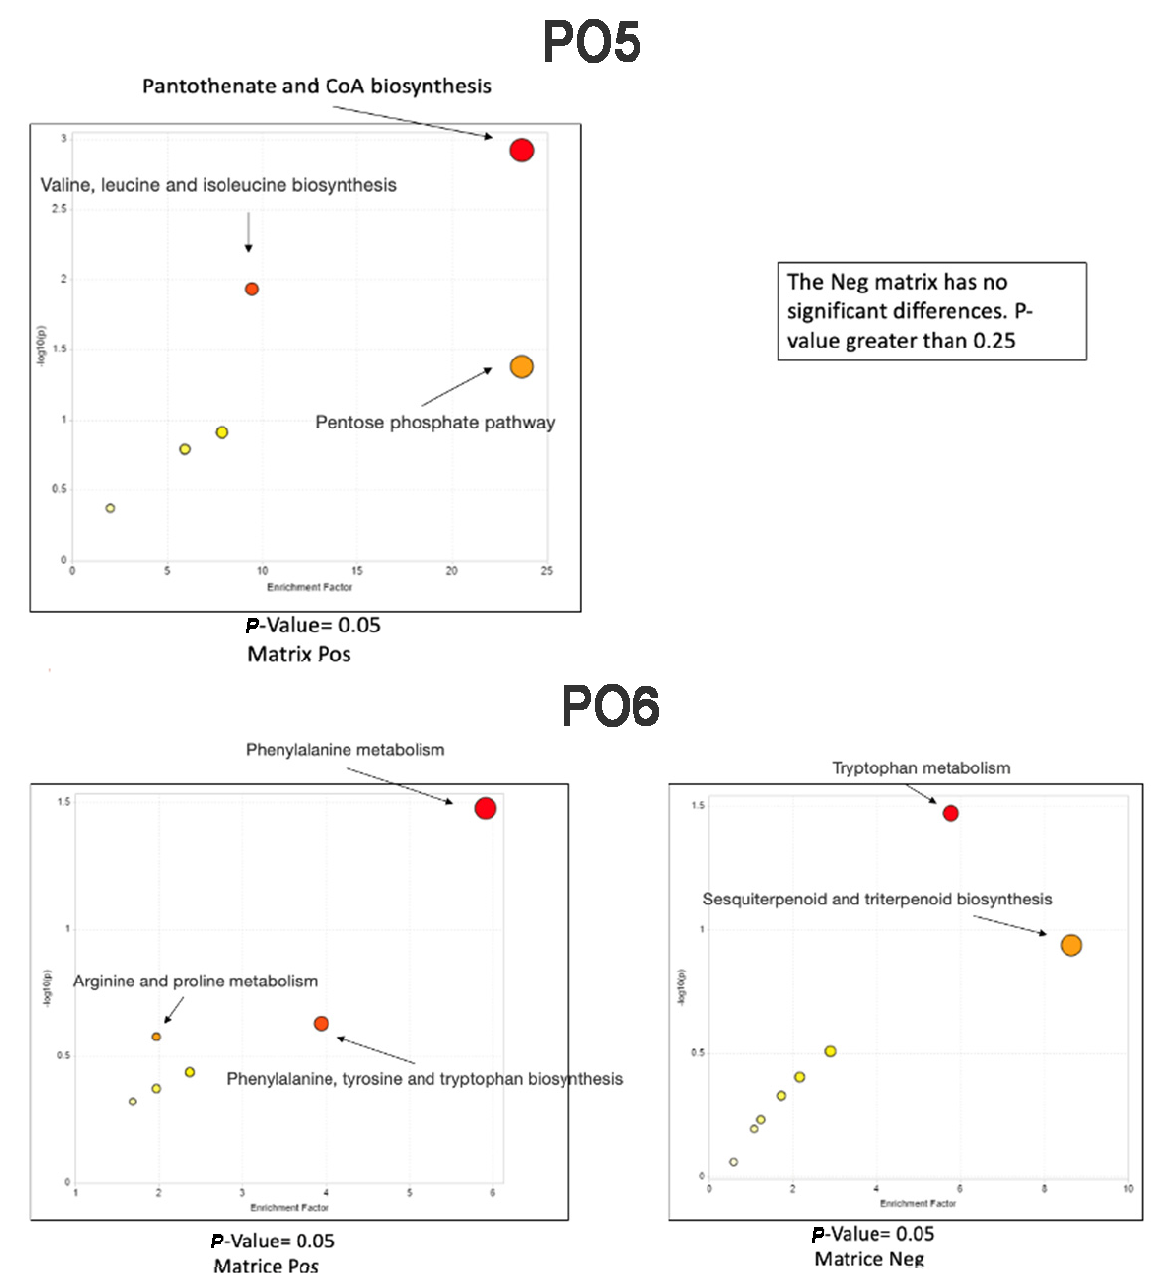
Figure 2. Mummichog Pathway Activity Profile: Comparison of metabolic networks present in samples in both polarities.